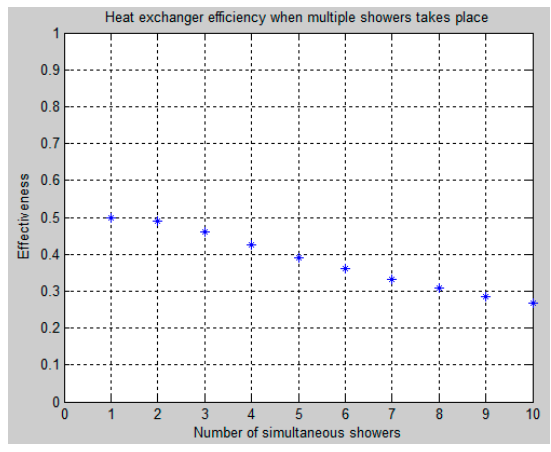
Figure 7. Heat exchanger effectiveness as a function of multiple simultaneous showers.